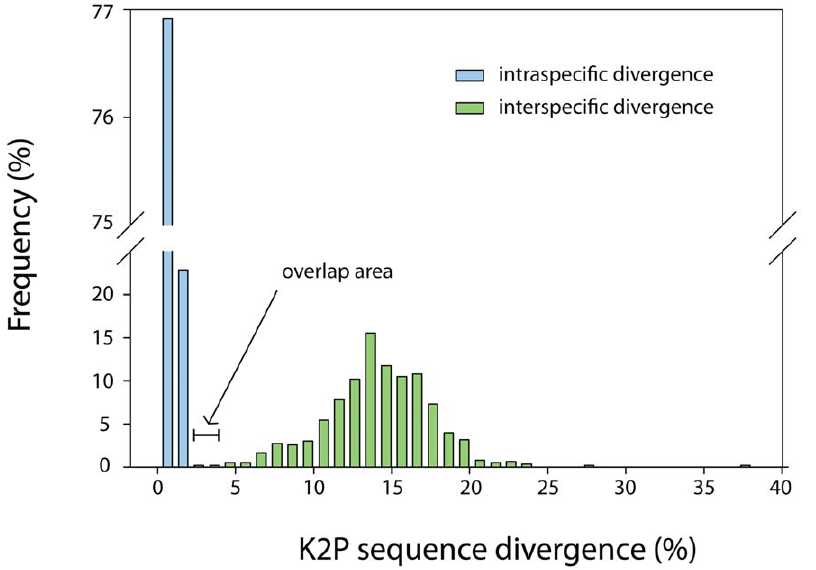
Figure 4. Combined histograms of pairwise Kimura 2-Parameter (K2P) sequence variation. Blue vertical bars show intraspecific divergences for the 20 species of Lymantria with multiple individuals and green vertical bars show the interspecific divergences between all 36 species.